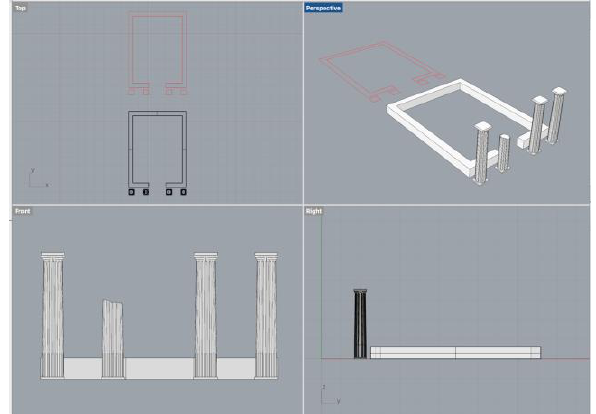
Figure 23. The Tomb of Persephores in Verghina. Construction of the 3D